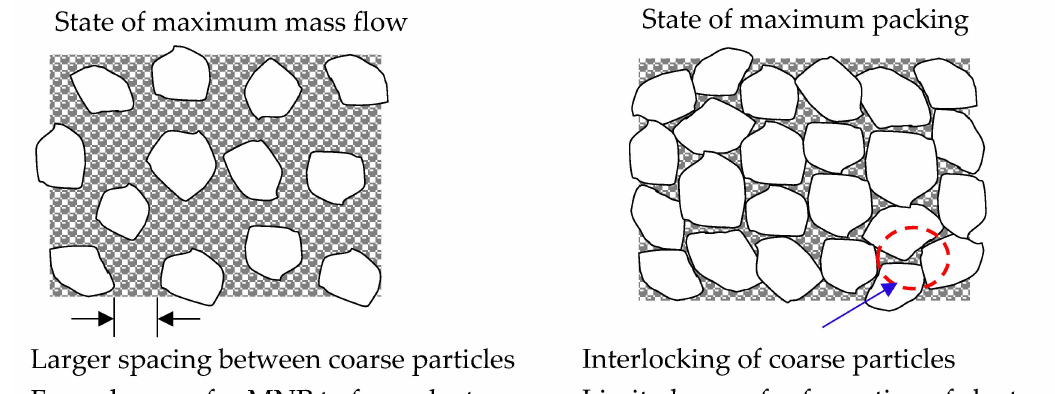
Figure 7. Effect of aggregate content (after [17]).